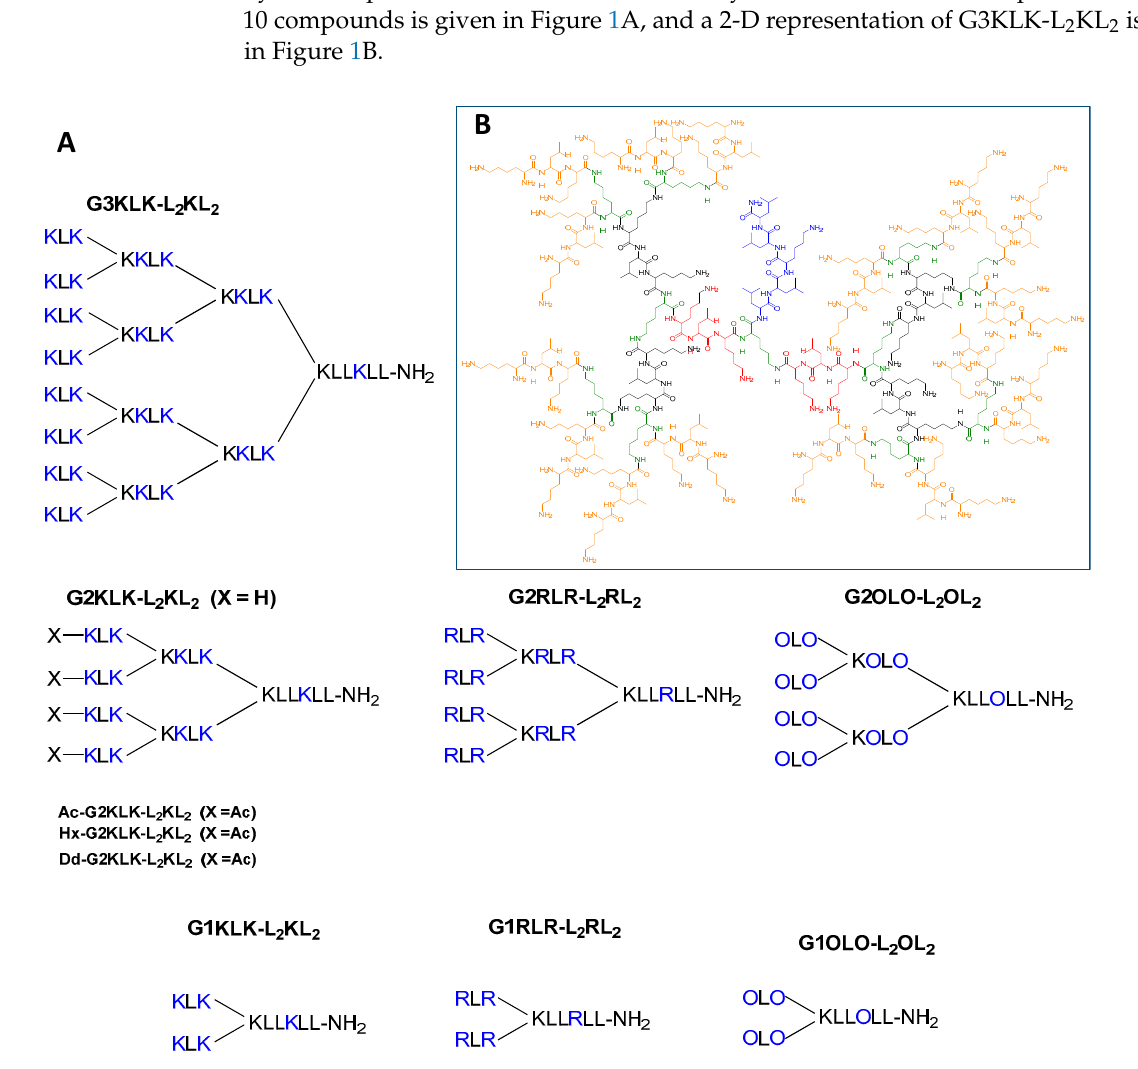
Figure 1. ( A ) Schematic representation of the peptide dendrimers synthesized. ( B ) 2-D representation of G3KLK-L 2 KL 2 ; the green residues are the branching Lys, then blue, red, black and orange indicate G0, G1, G2 and G3, respectively.2.2. .An- timicrobial Action (MIC and MBC).